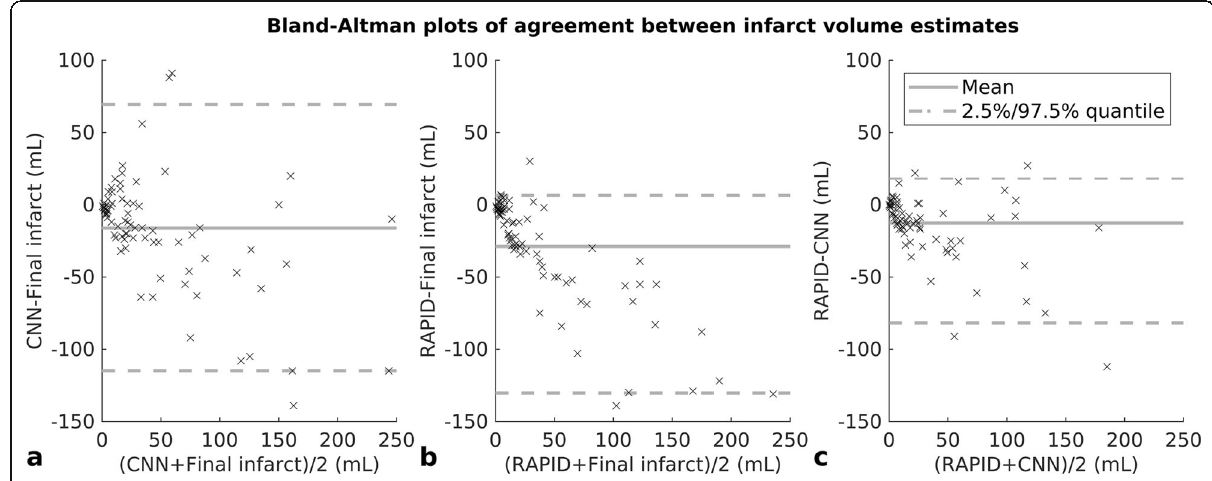
Fig. 5 Bland-Altman plots of agreement between lesion volume estimates. Convolutional neural network (CNN) predictions based on acute phase computed tomography angiography (CTA) and final infarct volumes ( a ), computed tomography perfusion RAPID (CTP-RAPID) ischaemic core (cerebral blood flow, CBF < 30%), and final infarct volumes ( b ) and CTP-RAPID and CNN ( c